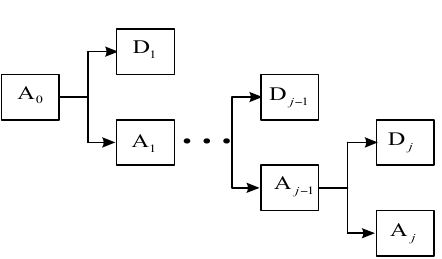
Figure 1. The multi-resolution singular value decomposition (MRSVD) process of a given signal.